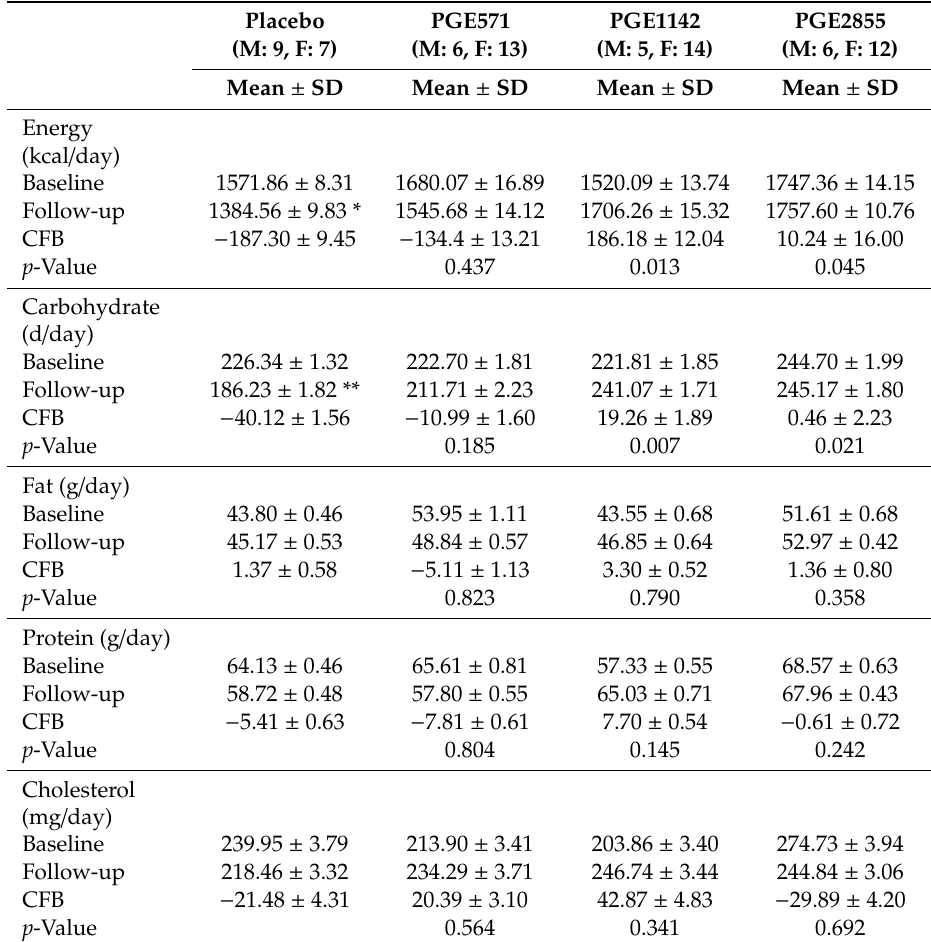
Table 3. Comparison of physical activity and nutrients intake in four groups with overweight or obesity by 24 h dietary recall performed before and in a follow-up of the